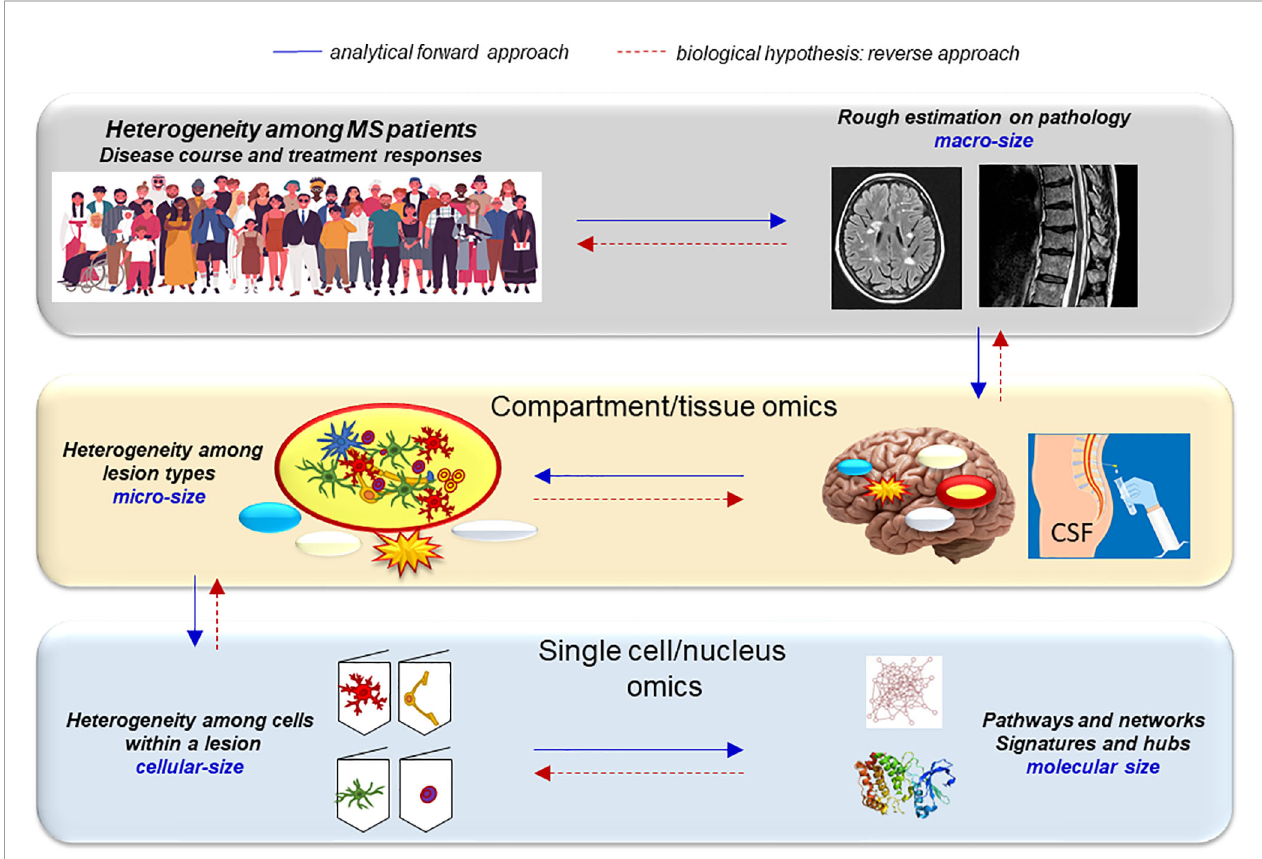
FIGURE 9 | Decoding the heterogeneity of MS with a reverse genetics approach. Analytical forward approach (blue arrows): The heterogeneity of the MS population is re fl ected by the heterogeneous course of MS and treatment responses. The hallmark of MS, WM brain lesions look similar on conventional MRI scans, but their histopathology is very different: characterized as active, inactive, chronic active and remyelinating/repairing lesions. This heterogeneity is most likely caused by the different cell types present in the lesions that is controlled by the heterogeneity of different networks and pathways activated within the cells and determined by some major hubs and molecular signatures. Biological hypothesis, reverse approach (red arrows): To decode this complexity, a reversed biological approach can be an alternative strategy. It can start from genetic regulation and molecular changes within individual cells that contribute to their fate. This will determine the evolution of lesions, and such complexity of lesion types will determine the individual MS brain and clinical outcomes. MS fate thus ultimately may depend on the interaction of singular